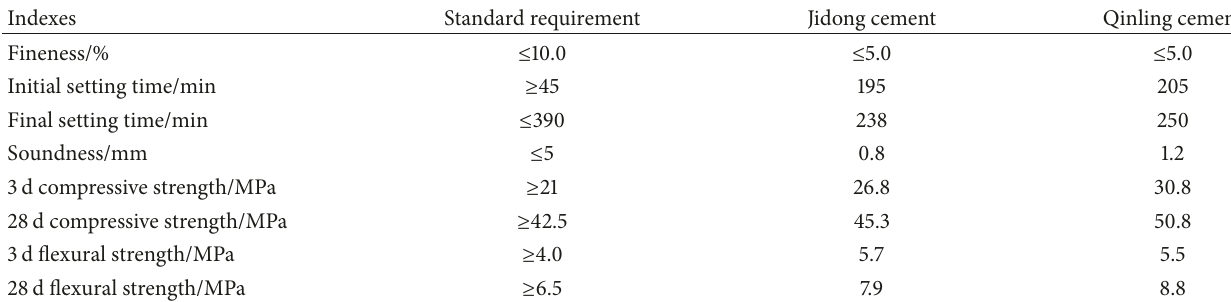
Table 1: Properties of Portland